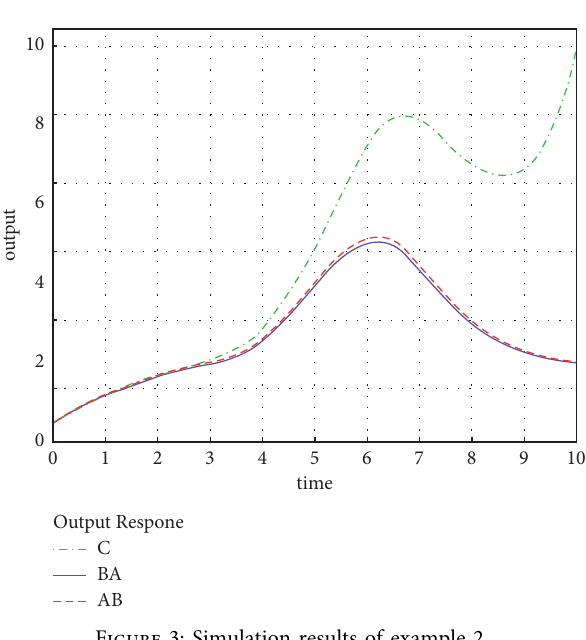
Figure 3: Simulation results of example